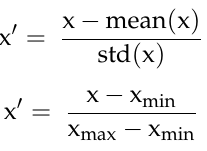
Figure 8. Flowchart of our RUL prediction approach.